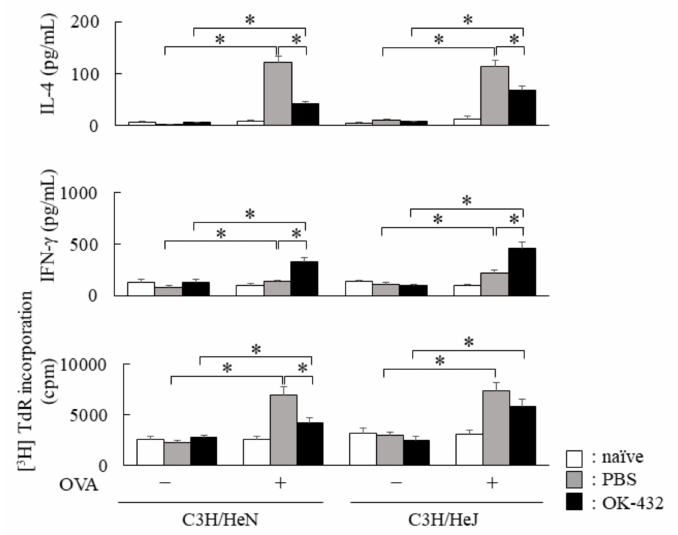
Figure 4. Cytokine production by spleen T cells from OK-432-treated or PBS-treated mice at the induction phase. The enriched T cells (5 × 10 5 cells) from the spleen of OK-432-treated (black bars) or PBS-treated (hatched bars) mice sensitized with OVA or naive mice (white bars) were cultured with OVA in the presence of MMC-treated spleen cells (5 × 10 5 cells) for 48 h at 37 ◦ C. All mice were immunized with OVA/ALUM. The proliferative responses of splenic T cells were measured by an incorporation of [ 3 H]TdR, and data was represented by CPM (counts per minute). IL-4 and interferon (IFN)- γ production by T cells was measured by an ELISA. The data are representative of four independent experiments using pooled cells from five mice and are shown as the mean of triplicate determinations ± SD. *, p <